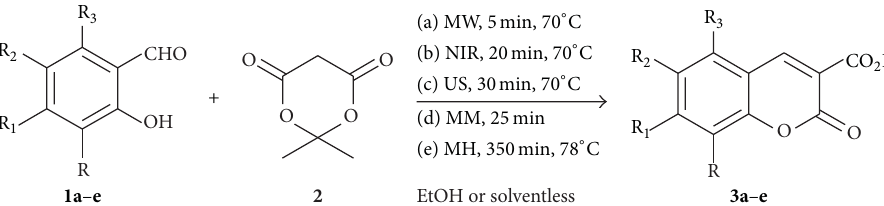
Scheme 1: Production of coumarins. Reagent or Product : a R = R 1 = R 2 = R 3 = H; b R = R 1 = H, R 2 = Me, R 3 = H; c R = Me, R 1 = R 2 = R 3